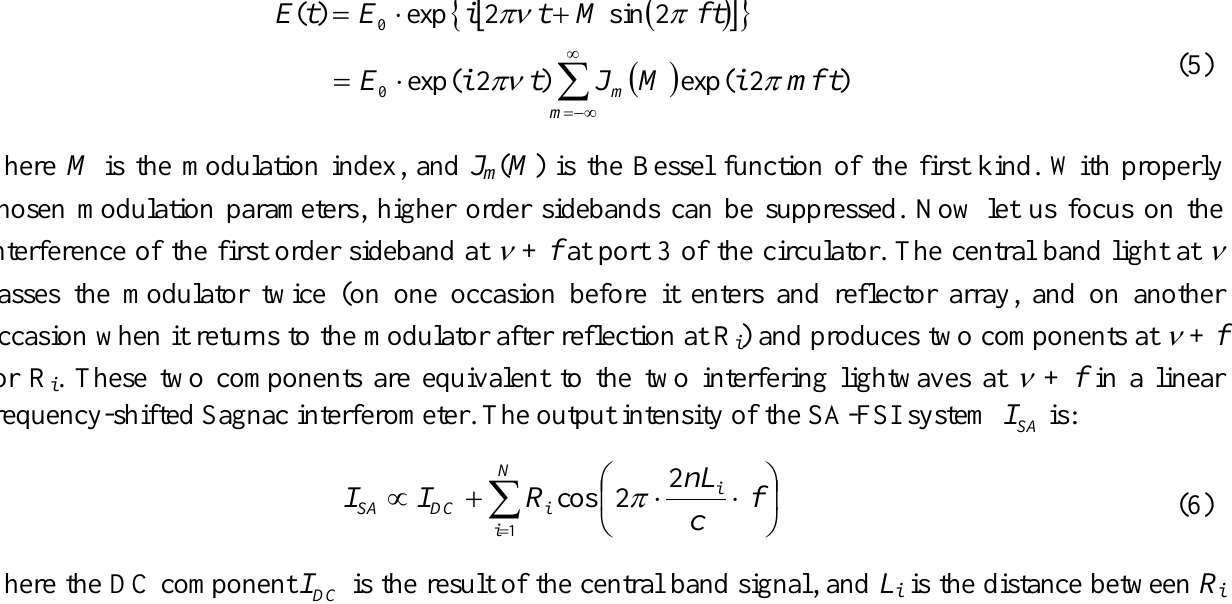
Figure 6. A single-arm frequency-shifted interferometer. R